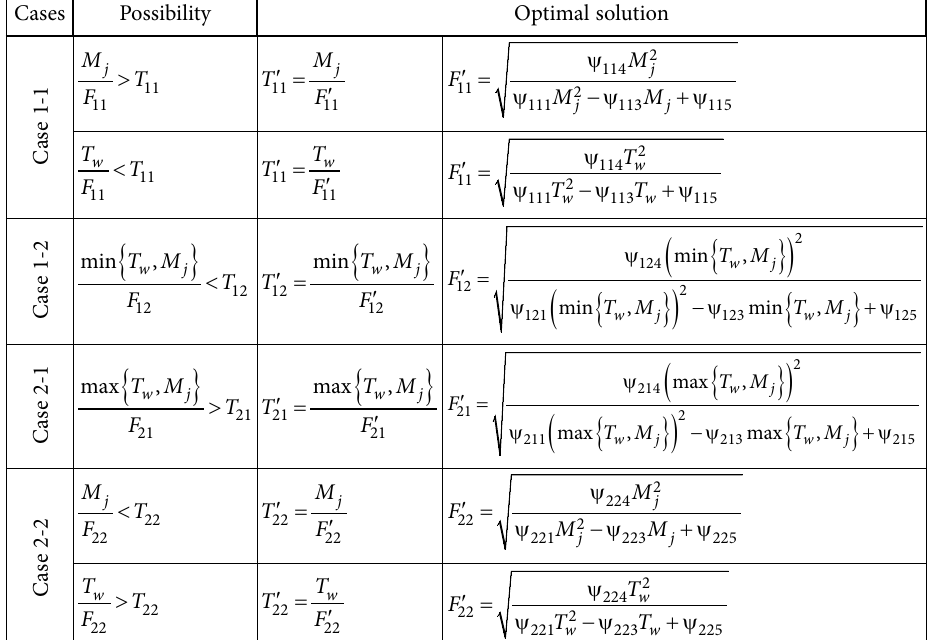
Table 2. The optimal solution if T and F don’t meet the condition Cases Possibility Optimal